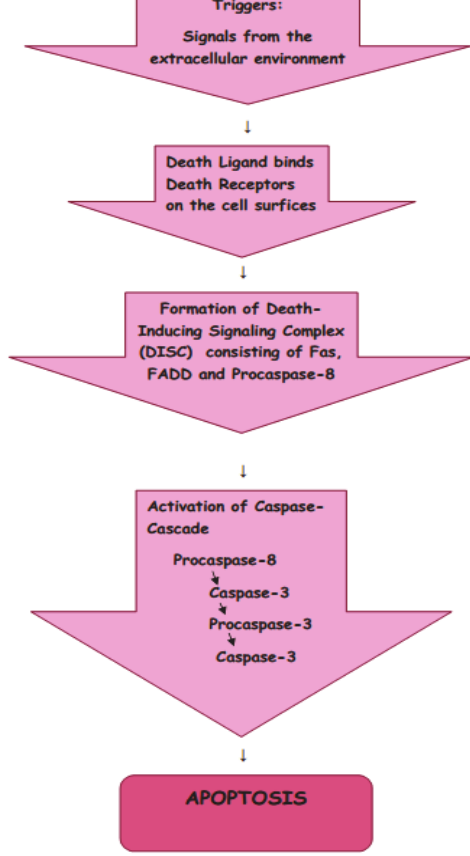
Figure 2. Extrinsic pathway of